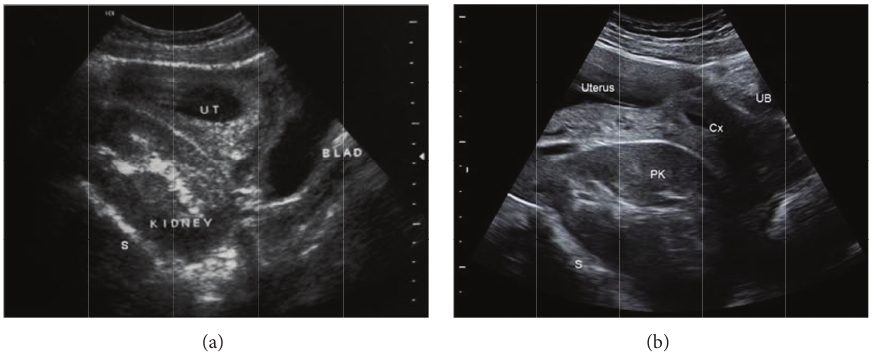
Figure 1: Transabdominal sonograms in the first and second trimesters. (a) shows a sagittal B-mode sonogram performed at the 12th gestational week. The pelvic kidney (PK) lies on the anterior sacral wall (S) below the uterus (UT) containing gestational sac. The inferoposterior wall of the urinary bladder (BLAD) touches the lower pole of the pelvic kidney. (b) demonstrates median plane sonogram performed at 23rd gestational week. Similar to (a) the pelvic kidney (PK) is deeply located in the maternal pelvis in front of the sacrum (S) and behind the uterine cervix (Cx). The uterus appears above the pelvic kidney. The empty urinary bladder is indicated by UB.